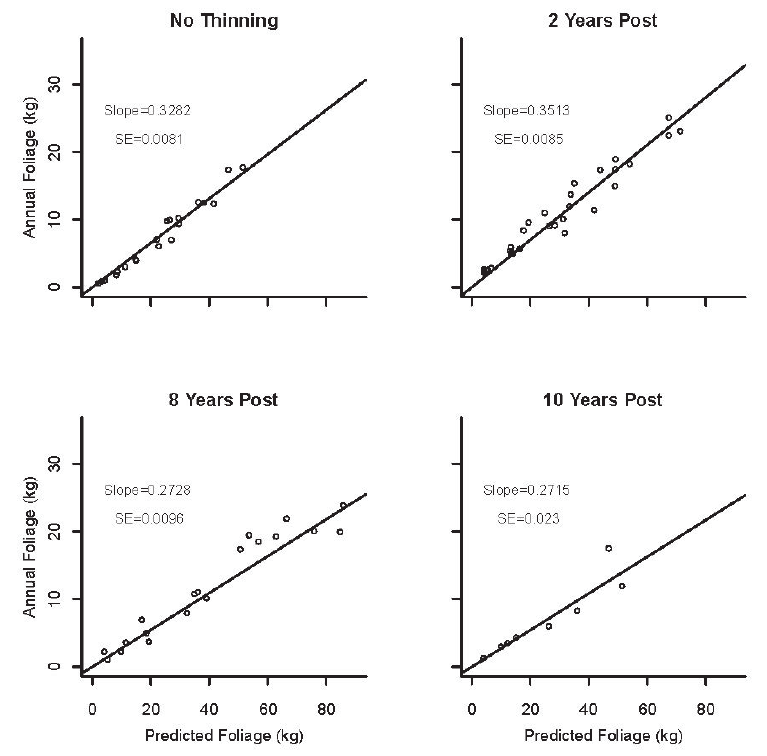
Figure 4. Tree-level annual foliage biomass production (kg) as a function of total foliage estimate (kg) across